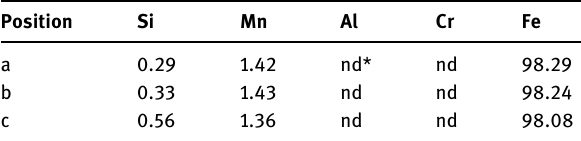
Table 5: SEM - EDS analyses of marked areas in the BC weld metal in Figure 4 ( mass% ) Position